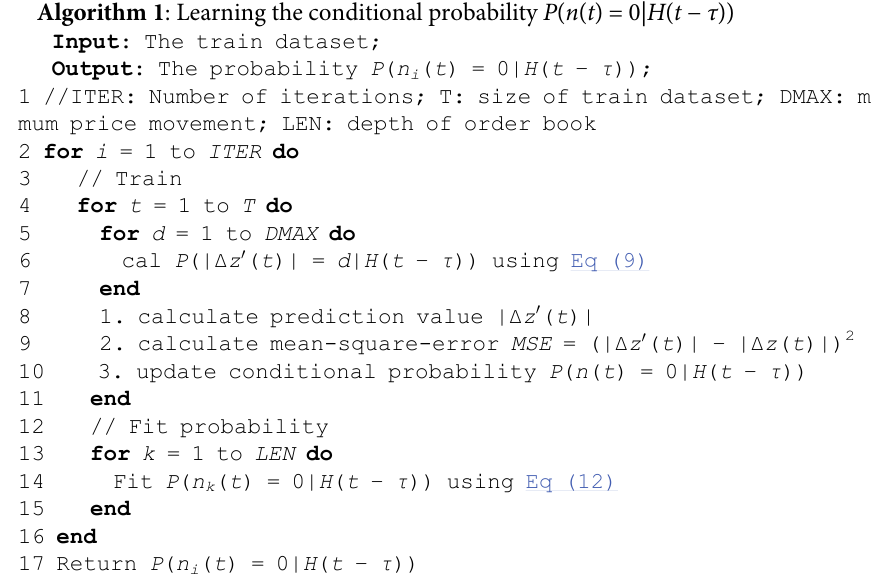
Algorithm 1 : Learning the conditional probability P ( n ( t ) = 0| H ( t − τ